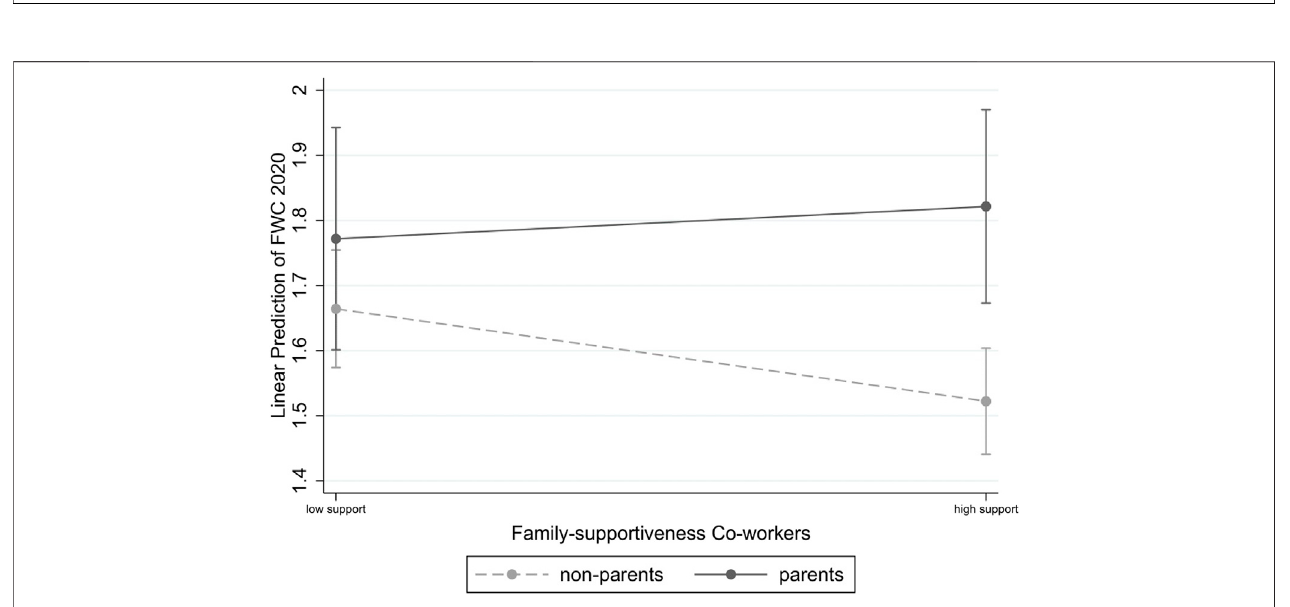
FIGURE 4 | Relationship between Parenthood Status and Co-workers Family-supportiveness on Parents and Non-Parents FWC. Note: Results based on Model M4, in Table 7 . 90% con fi dence bands.